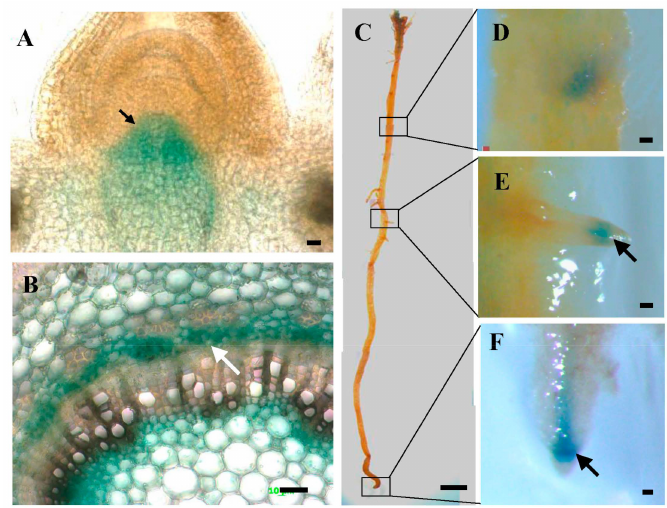
Figure 2. Spatial expression patterns of PtoWUSa detected by GUS staining. ( A , B ) Spatial expression patterns of PtoWUSa in the longitudinal section of shoot apex ( A ) and cross-section of stem ( B ). ( C – F ) Expression patterns of PtoWUSa in root ( C ); LRT ( D and E ) and ART ( F ) were close-ups of the boxed regions in ( C ). Arrows highlighted the GUS signal. Scale bars: ( A ) = 20 µ m; ( B ) = 10 µ m; ( C ) = 5 mm; ( D , E ) = 500 µ